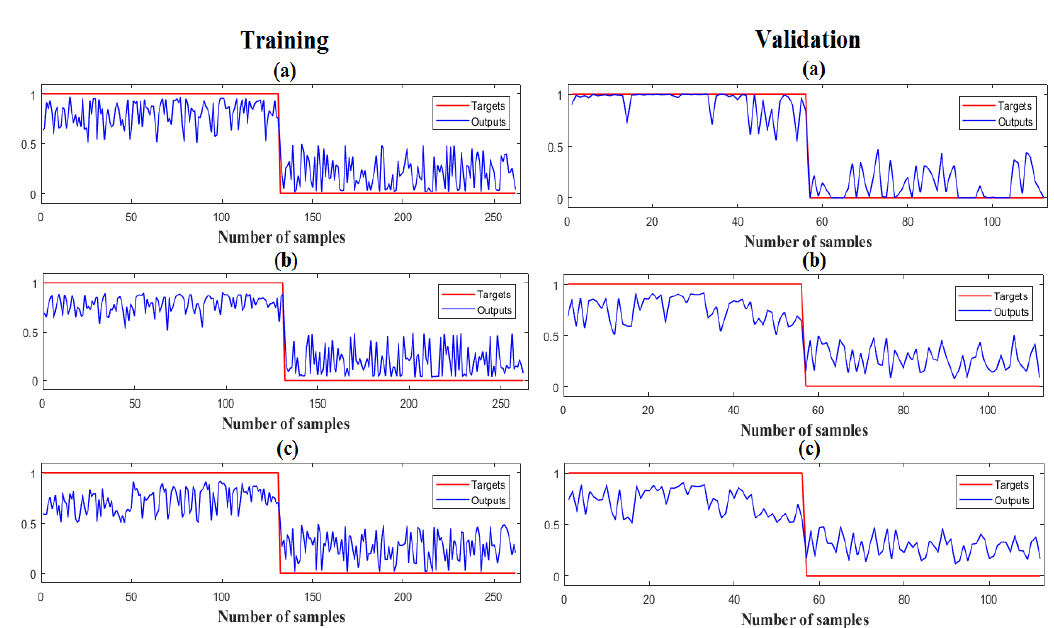
Figure A1. Results of the hybrid models: ( a ) BayesNet-GA, ( b ) BayesNet-SA, ( c ) BayesNet-TS.